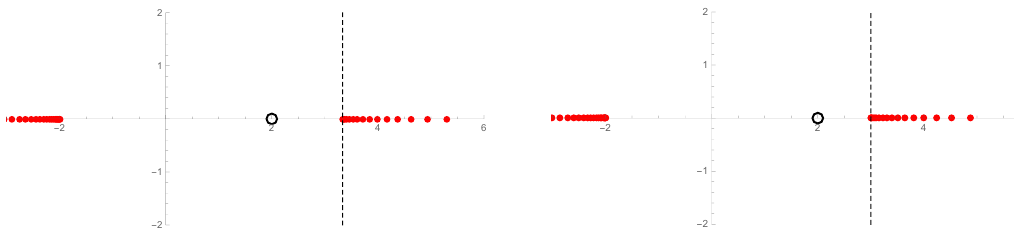
Figure 4 . The poles of the Borel-Padé approximant of the series ¯ e m in (3.74) truncated at 120 terms. The plots correspond to the Gross-Neveu model with N = 7 (left) and N = 8 (right). The dashed vertical line indicates the predicted position of first unconventional renormalon singularity ζ = 2 / Υ . The black circle indicates the position of the removed IR singularity at ζ = 2